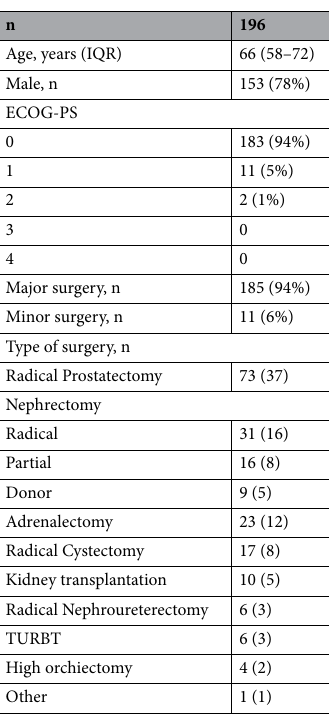
(Fig. 3D). The median total cfDNA before and after surgery for other surgeries was 1.0-fold for minor surgery, 2.3-fold for laparoscopic RNU, and 4.7-fold for KT (Fig. 3E). Exploratory outcome. There was no significant correlation between the postoperative increase ratio of WBC (Fig. 4A), increase ratio of CRP (Fig. 4B), surgical time (Fig. 4C), and estimated blood loss (Fig. 4D) with total cfDNA before/after ratio, regardless of the type of surgery. There was also no correlation between the con- ventional surgical damage markers and postoperative total cfDNA levels.